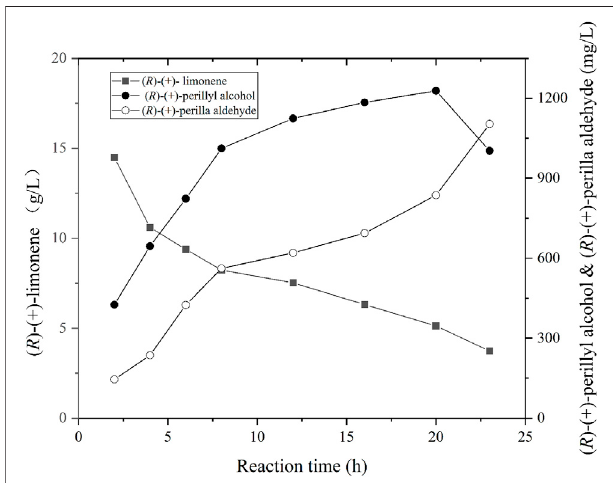
FIGURE 5 | Time course of ( R )-(+)-limonene hydroxylation using whole cell of strain 10. Reaction conditions (1 L): whole cell catalysts (OD 600 =